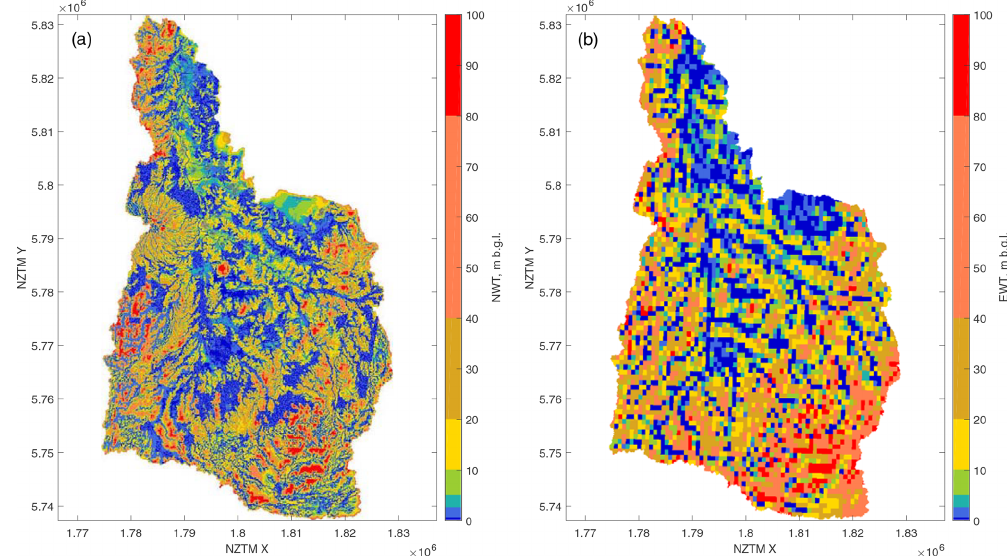
Figure 13. Water table depth of the (a) NWT and (b) EWT models in the Waipa River catchment.